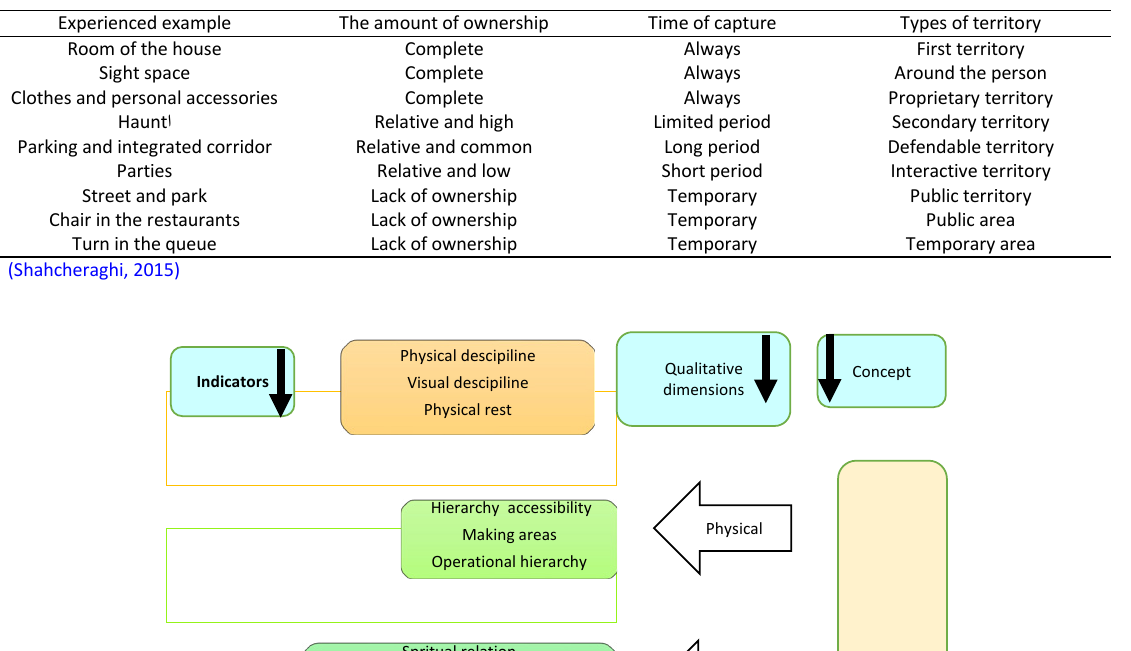
Table 1: Types of spatial territory